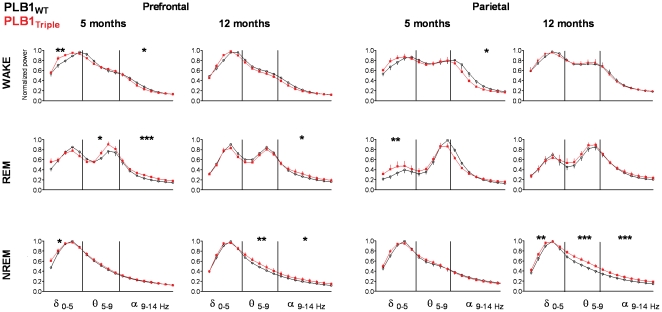
Vigilance-stage specific EEG power spectra in PLB1WT and PLB1Triple animals at 5 and 12 months of age.Normalised power spectra (delta - alpha bands) from specified vigilance stages are depicted for recording sites above the prefrontal cortex (left) and parietal cortex (right), significances between genotypes are indicated per frequency band. A shift towards lower frequencies and thus a rise in delta power was observed at 5 months, while NREM EEGs showed global genotype- and age-related changes at 12 months. *: P<0.05; **:P<0.01; ***: P<0.001.